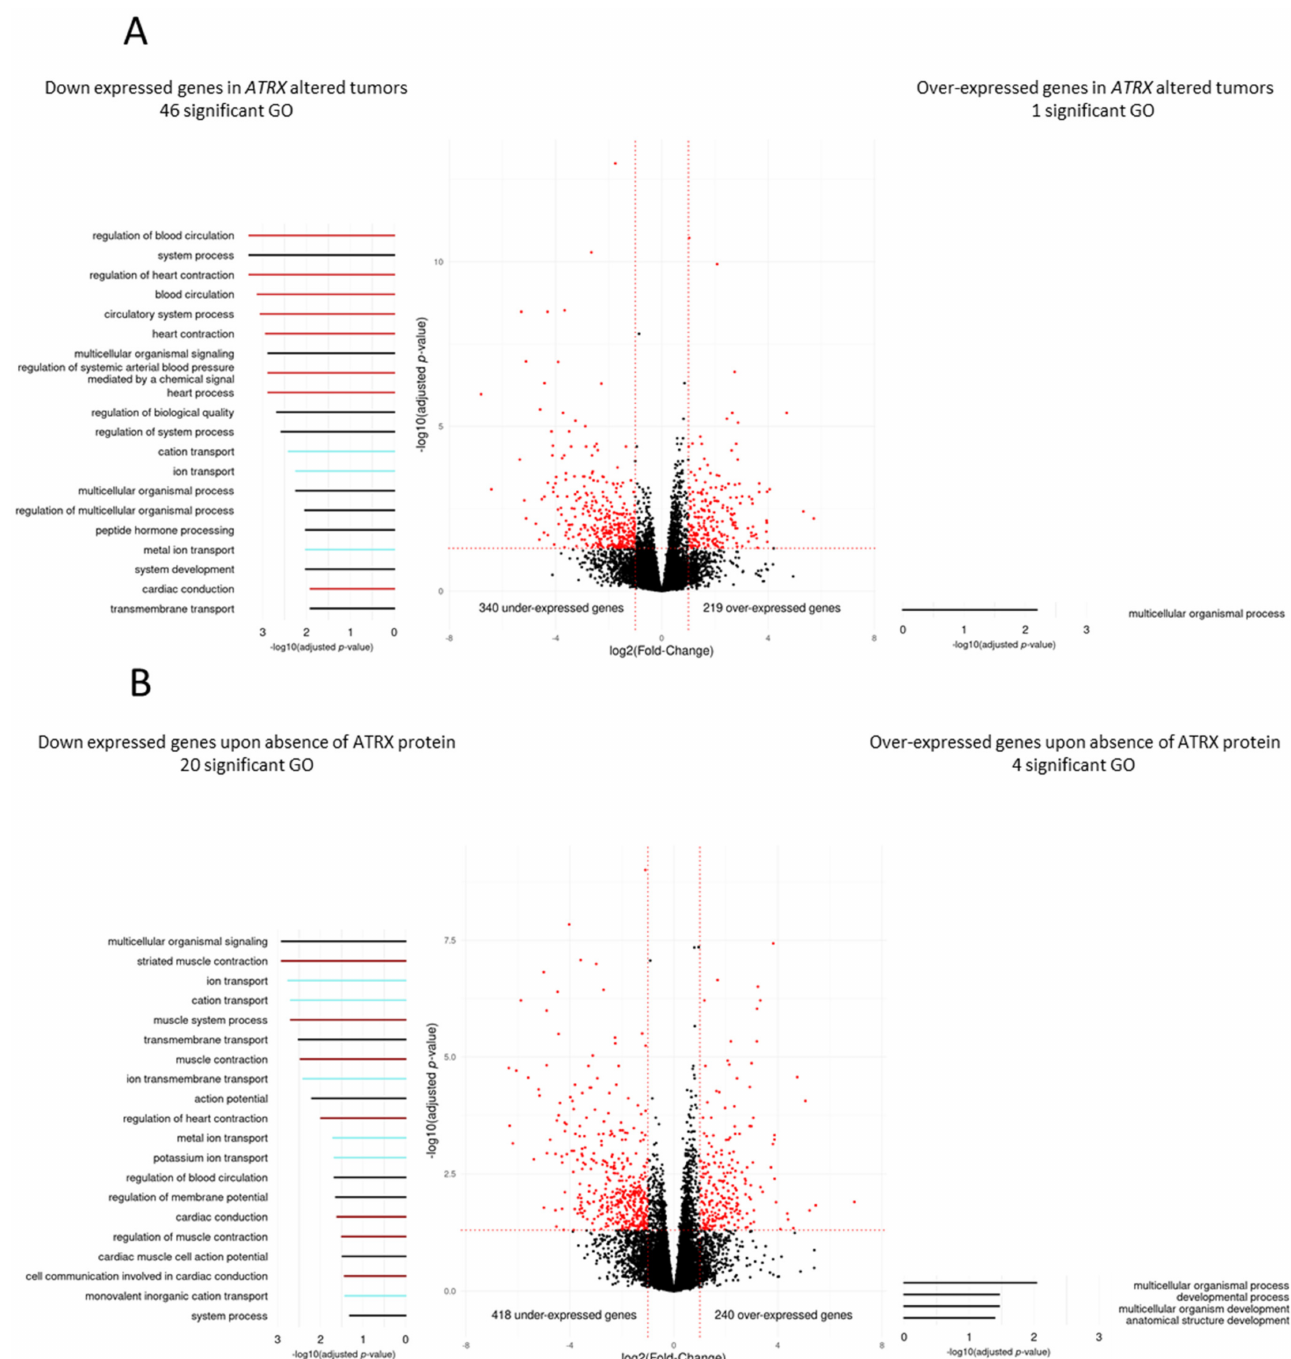
Figure 2. Differential gene expression and Gene Ontology analyses according to ATRX alteration in leiomyosarcomas (Cohort 1). Differentially expressed genes according to ( A ) ATRX status (wild-type vs. altered) or ( B ) ATRX expression (nucleus vs. absent). Red dots indicate significant genes ( p ≤ 0.05 and fold-change ≤− 2 or ≥ 2). Gene Ontology (GO) analyses, represented on the left (under-expressed genes) and the right (over-expressed genes), identified 46 and 1 significant GO terms ( p ≤ 0.05), respectively in ( A ) and 20 and 4 significant GO terms ( p ≤ 0.05) in ( B ). On each side, the 20 most significant GO terms are represented and color-coded by mechanisms; light red, dark red, light blue, and black colors indicate “circulatory system process”, “muscle system process”, “ion transport” and general terms, respectively. For ATRX localization, the “absent” group means “not at the nucleus”, including all cases without expression and the case with a cytoplasmic localization (LMS16). All p -values were adjusted by Benjamini and Hochberg